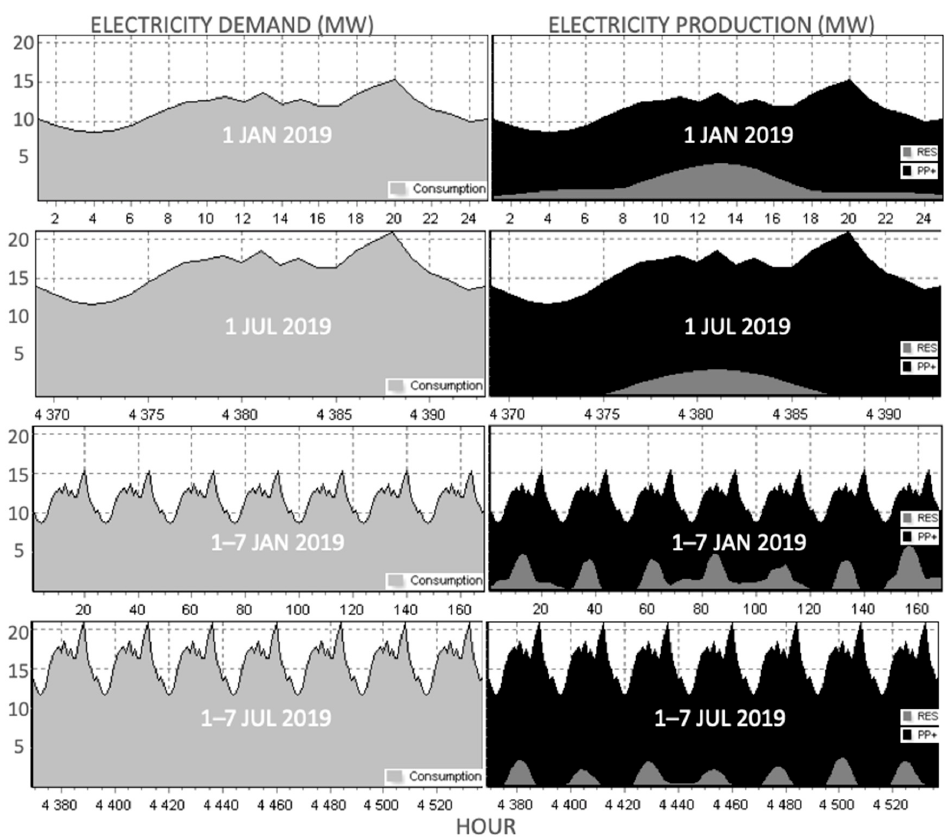
Figure 2. The daily and weekly electricity demand and production in Isla de la Juventud in January and July 2019. Data source: